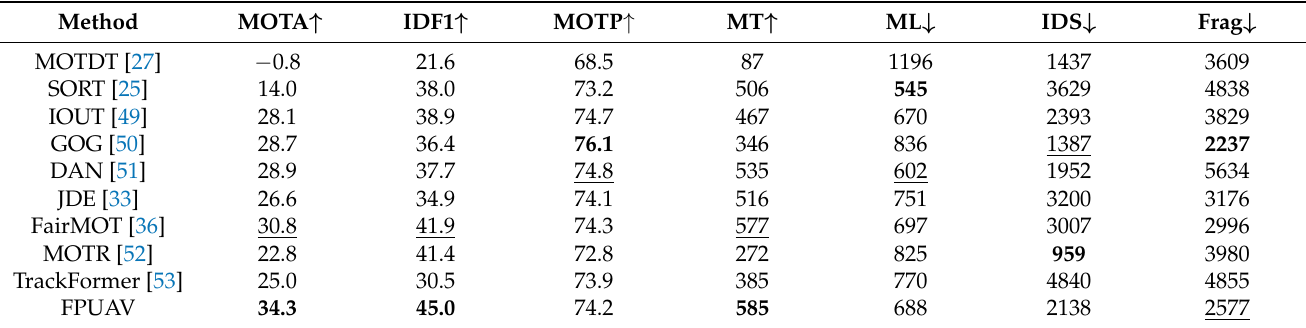
Table 1. Comparison with state-of-the-art methods on VisDrone2021.